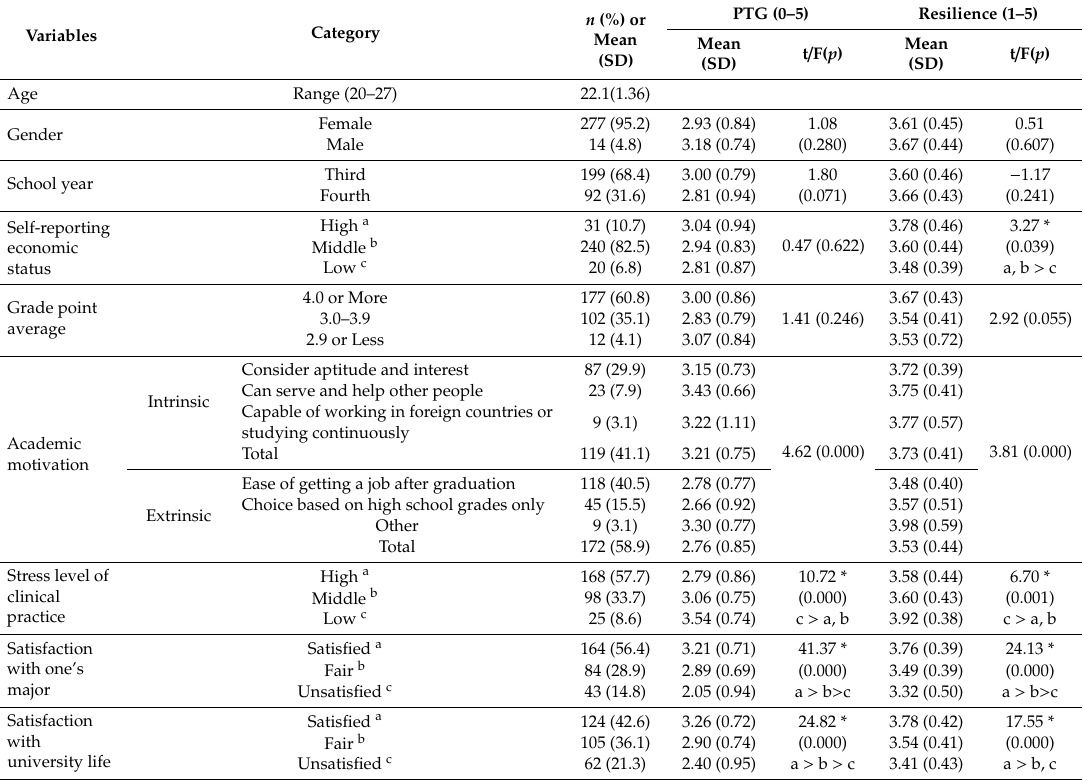
Table 1. Di ff erences in post-traumatic growth (PTG) and resilience according to general